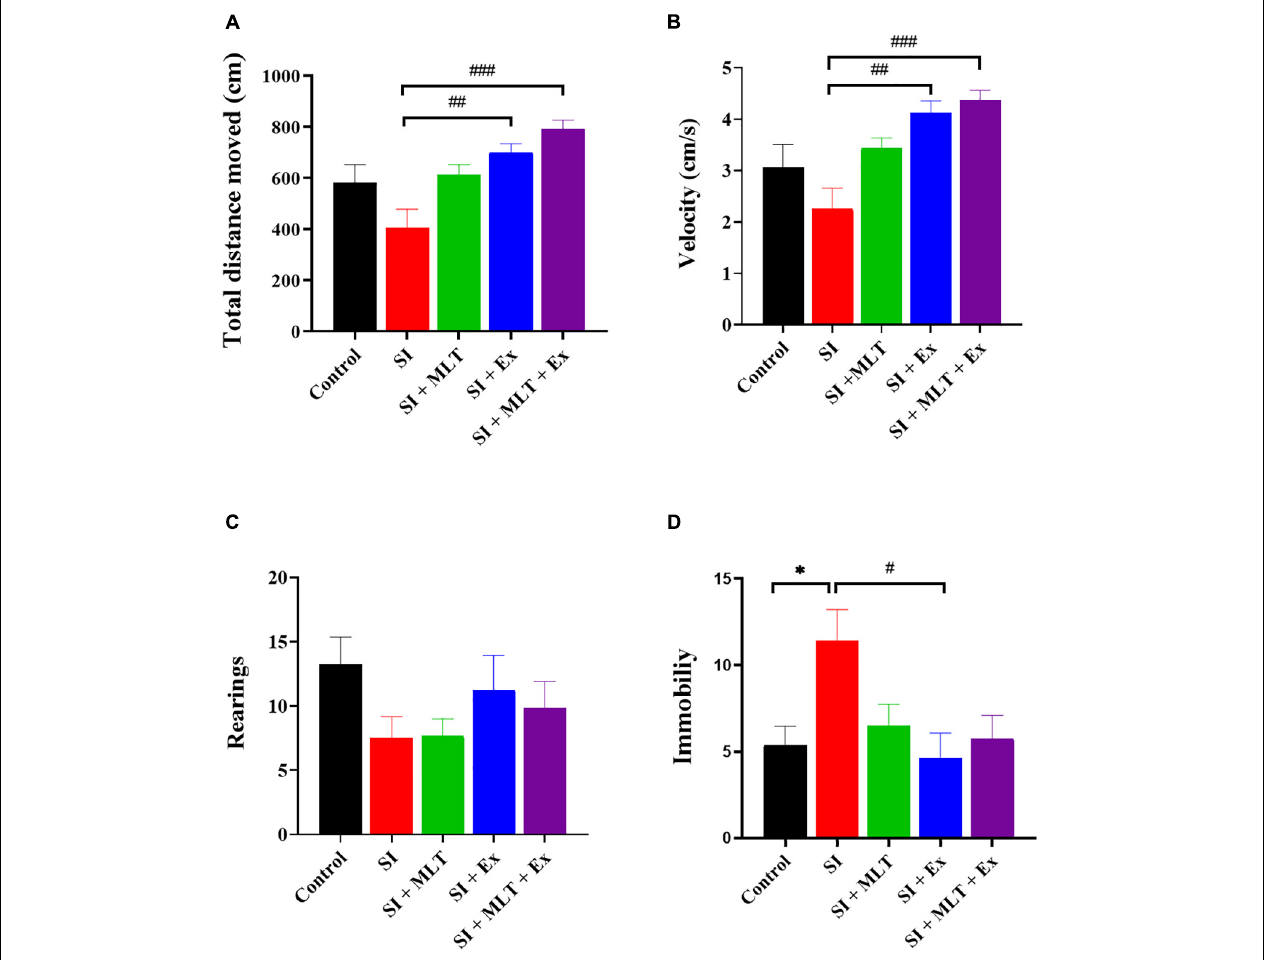
FIGURE 3 | The effect of MLT and Ex in the open field test on (A) total distance moved, (B) velocity, (C) rearing frequency, and (D) immobility frequency among groups. Data are presented as the mean ± SEM. One-way ANOVA was used, followed by Tukey’s multiple comparisons test. ∗ indicates a significant difference between the treated groups and the control group at p > 0.05; # indicates a significant difference between the treated groups and the SI group at p > 0.05; ## P < 0.01; ### P < 0.001.